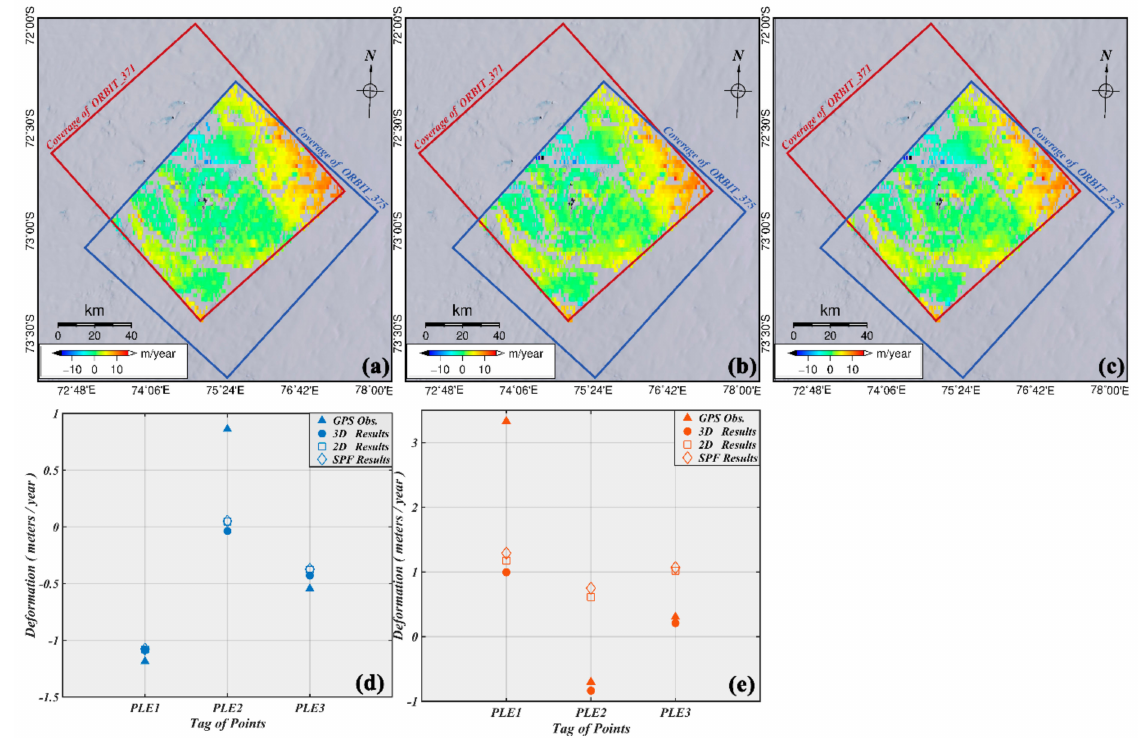
Figure 8. Differences between the MEaSUREs data and the amplitudes of the complete 3D ( a ), 2D ( b ), and quasi-3D ( c ) results, respectively. Comparisons between the GPS observations and different results in the east ( d ) and north ( e ),